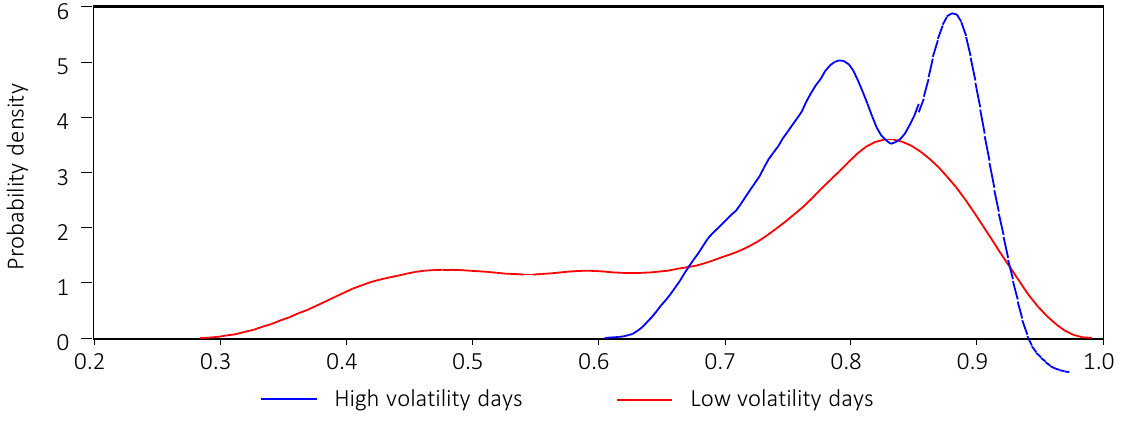
Figure 2(b). Distributions of DCC between London and New York gold markets on low and high volatility